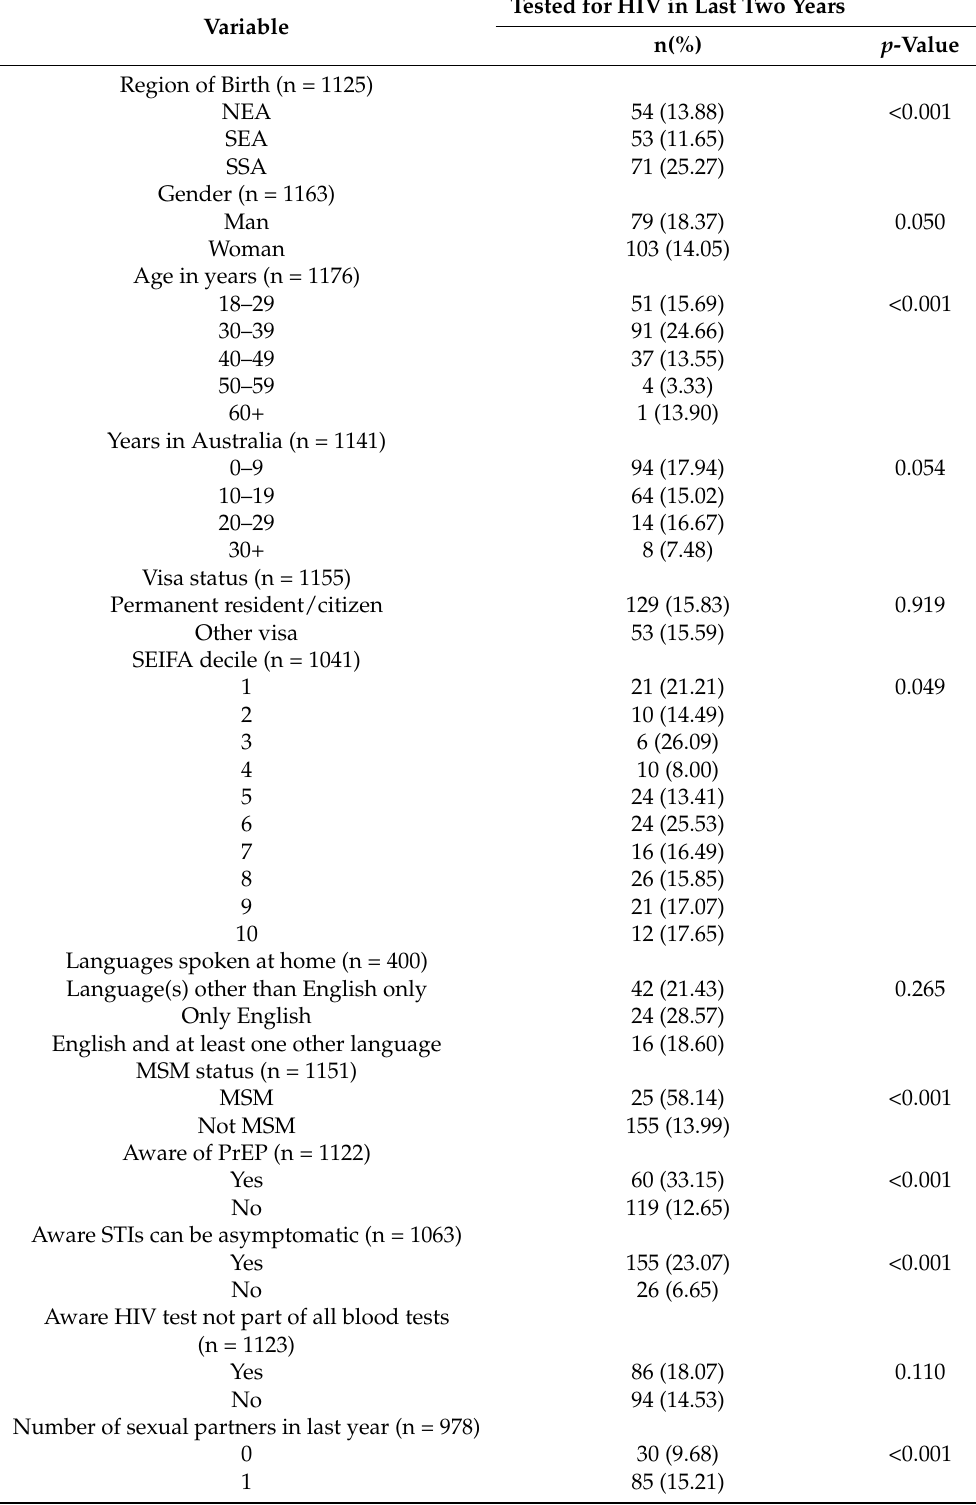
Table 7. HIV testing, by socio-demographic factors, HIV knowledge, and sexual practices.